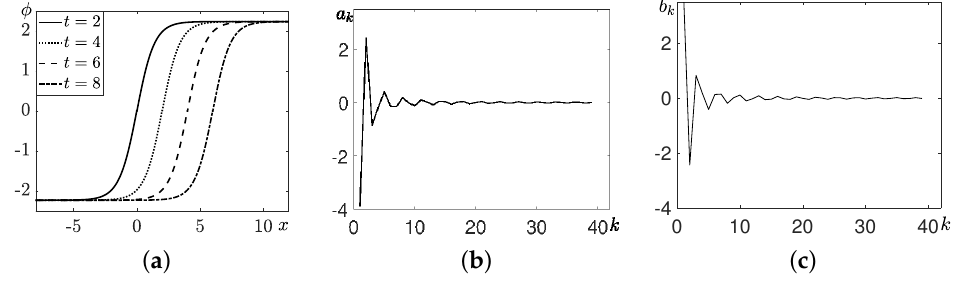
Figure 2. The parameters are chosen as in Figure 1a. ( a ) The series solution in (98) for the heteroclinic orbit in Figure 1a. The solution is drawn as a function of x for different values of t , showing the traveling-wave nature of the obtained front solution. ( b ) The chosen value a 1 = − 3.9083, solution of the continuity Equation (118) truncated at M = 40, leads to convergent series coefficients a k . ( c ) The series coefficient b k = − a k of the solution φ − ( z ) is then also